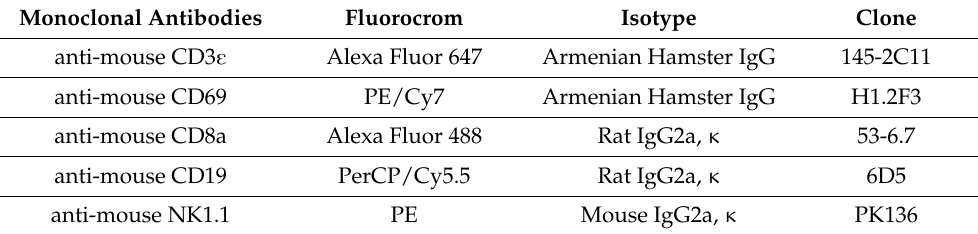
Table 2. Monoclonal antibodies used for the CD69 marker expression analysis. Monoclonal